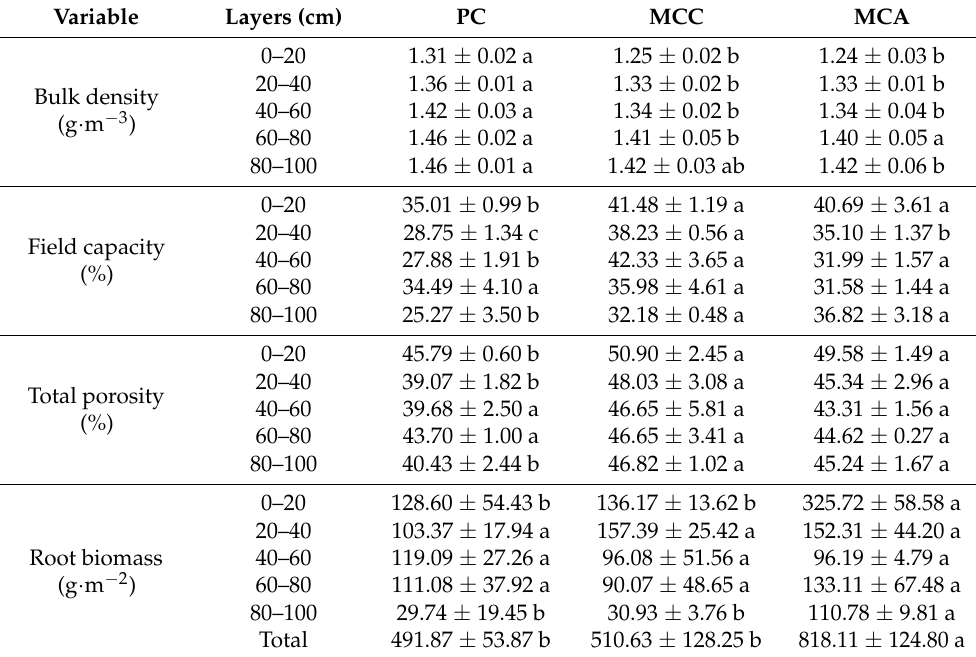
Table 2. The soil properties and root biomass among the three plantations.